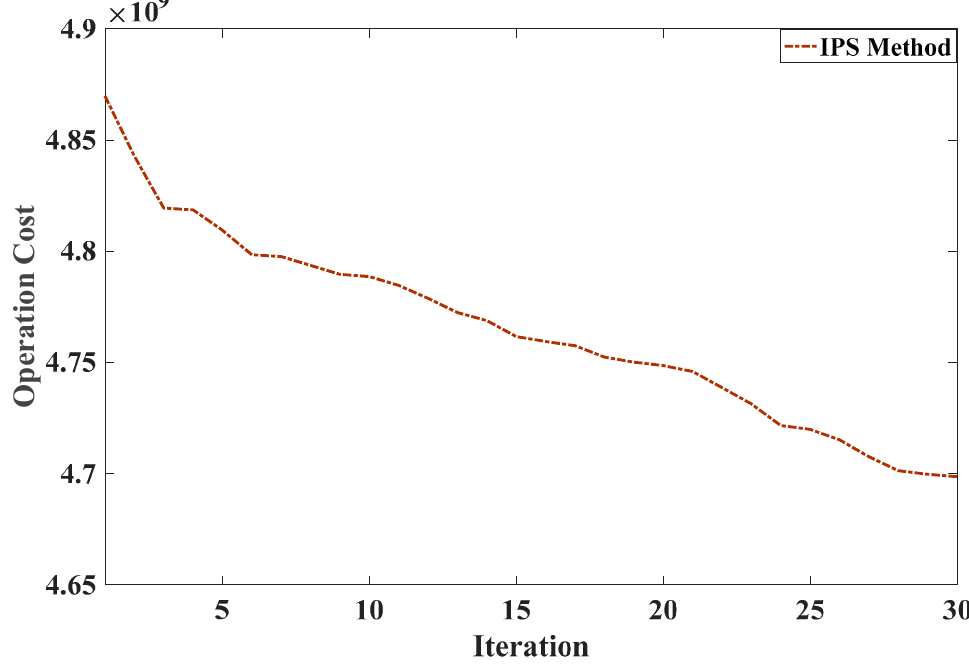
Figure 9. Evaluating the different optimization algorithms for F-score.